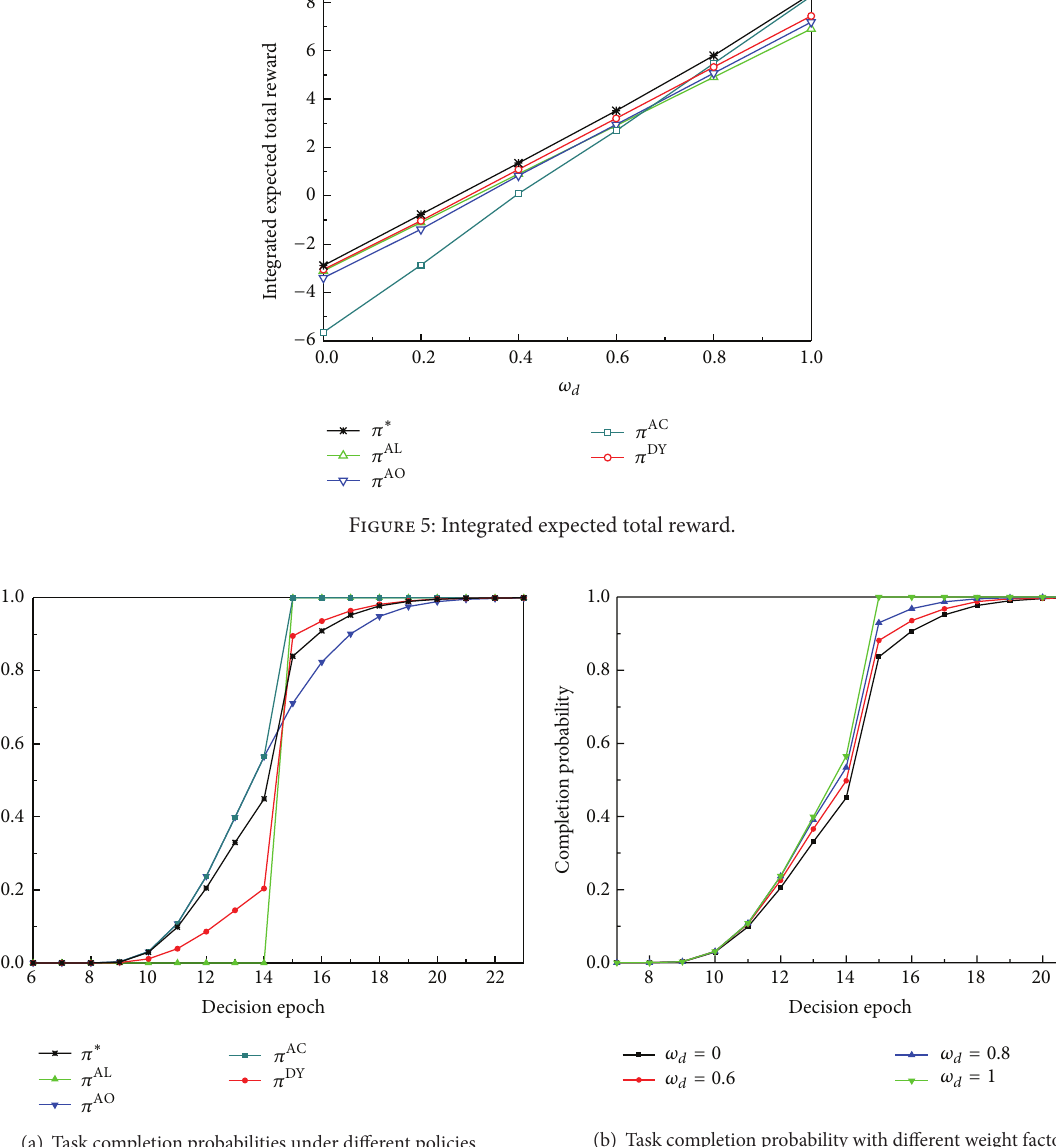
Figure 6: Task completion